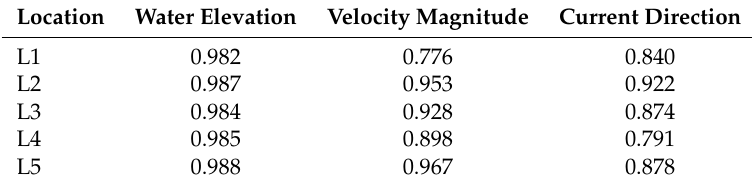
Table 1. NSE efficiency of model predictions at five different locations shown in Figure